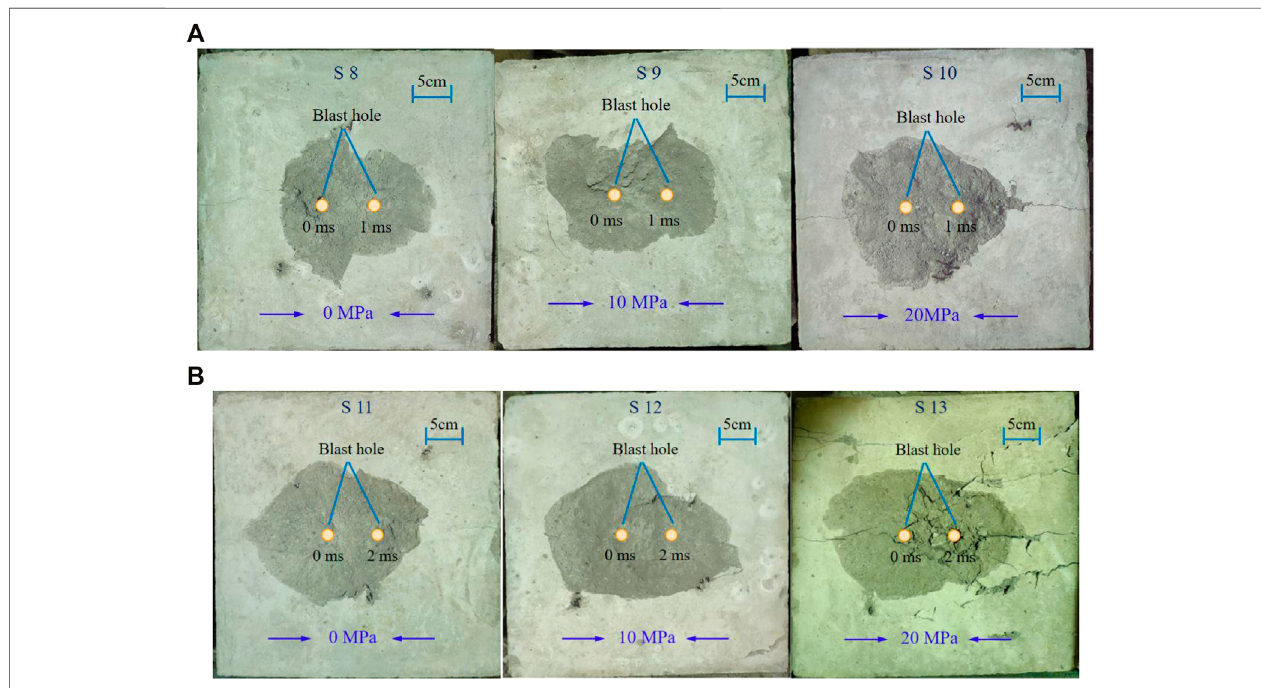
FIGURE 11 | Crater shape of double-hole short-delay initiation blasting under con fi ning pressure loading. (A) 1 ms delay between holes. (B) 2 ms delay between holes.